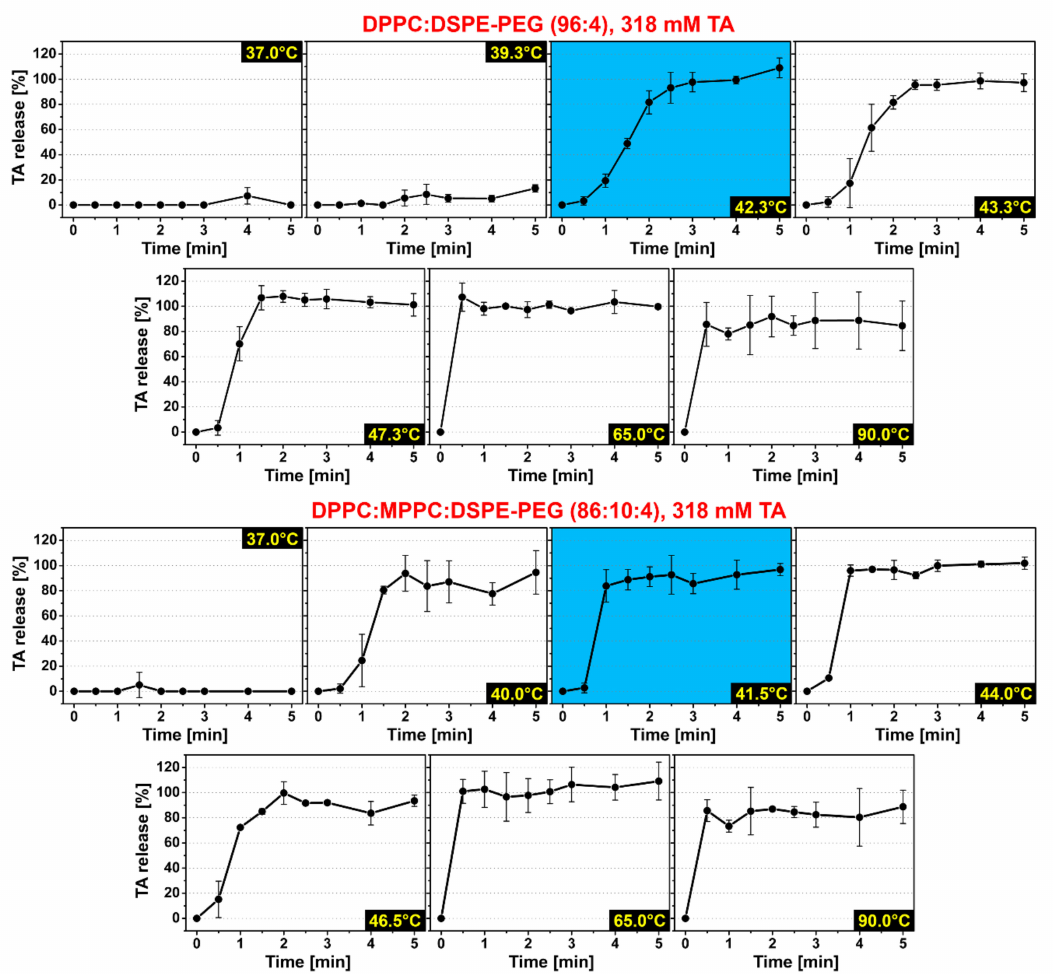
Figure 3. Heat-induced tranexamic acid (TA) release from DPPC:DSPE-PEG (96:4) large unilamellar vesicles prepared by the extrusion technique (LUVETs) (top) and DPPC:MPPC:DSPE-PEG (86:10:4) LUVETs (bottom) plotted as a function of heating time at varying temperatures from 37.0 to 90.0 ◦ C. Temperatures are indicated in the black labels. The panels in blue represent heating at T = T m as measured by di ff erential scanning calorimetry (Figure S7). Released TA concentration is expressed as a mean ± SD percentage of total liposomal TA content (N = 3–6 per time point from independent experiments conducted by 3 researchers). TA release from DPPC:MPPC:DSPE-PEG (86:10:4) LUVETs at 36 ◦ C [16] is not shown because the data furnish no additional value to the release kinetics presented at 37 ◦ C. The TA release kinetics from DPPC:DSPE-PEG (96:4) LUVETs at 39.3 and 42.3 ◦ C and the TA release kinetics from DPPC:MPPC:DSPE-PEG (86:10:4) LUVETs at 41.5 ◦ C were adapted from [16]